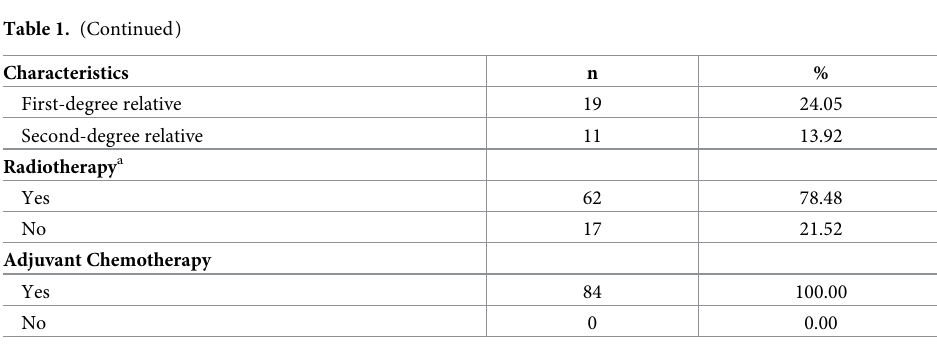
PLOS ONE | https://doi.org/10.1371/journal.pone.0218030 June 20,